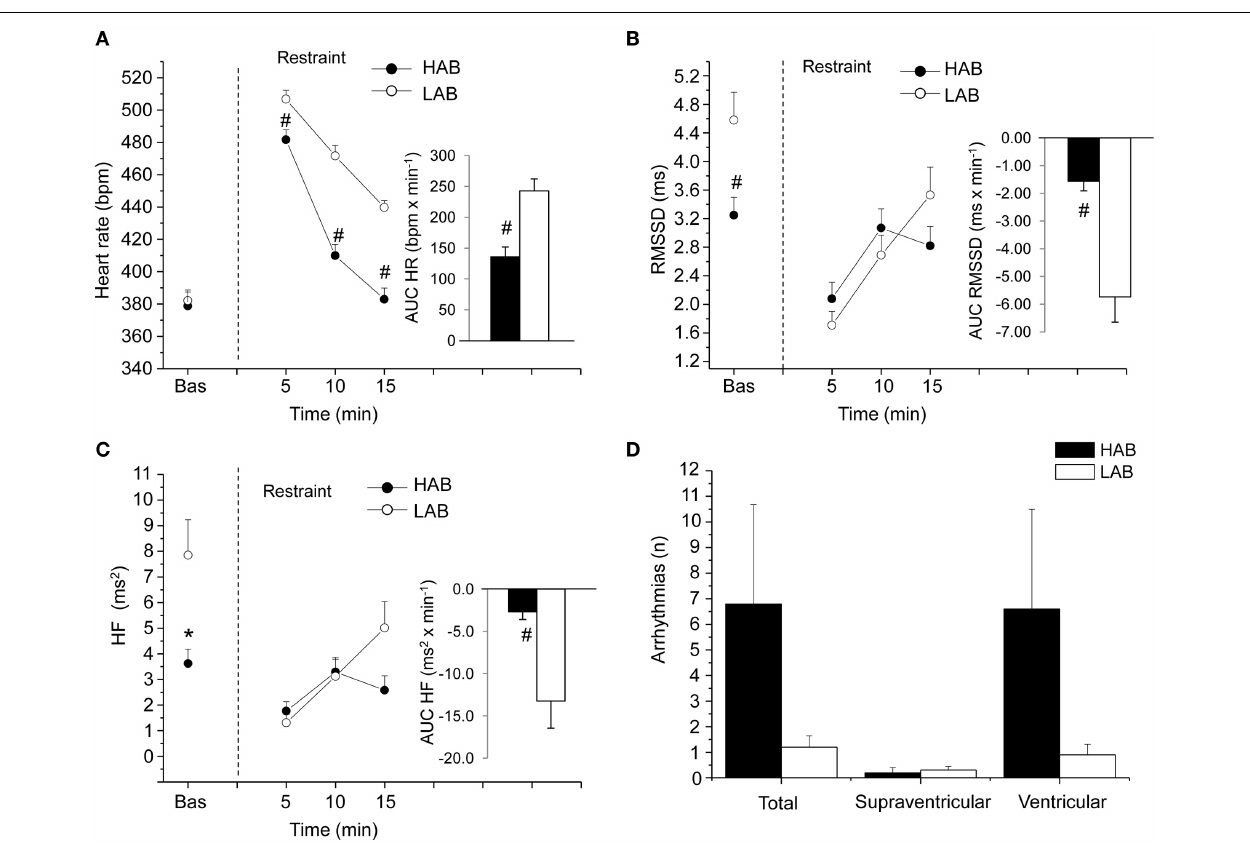
FIGURE 5 | Cardiac response to a restraint stress test in 4-mont-old Wistar rats selectively bred for either high (HAB, n = 10) or low (LAB, n = 10) anxiety-related behavior. Panels (A–C) show the time course of changes in heart rate, RMSSD values and high-frequency (HF, 0.75–2.5Hz) spectral power in baseline conditions (bas, 30min) and during the restraint test (15min), respectively. Each point during the restraint phase is the mean of 5-min intervals. Inner graphs in (A–C)